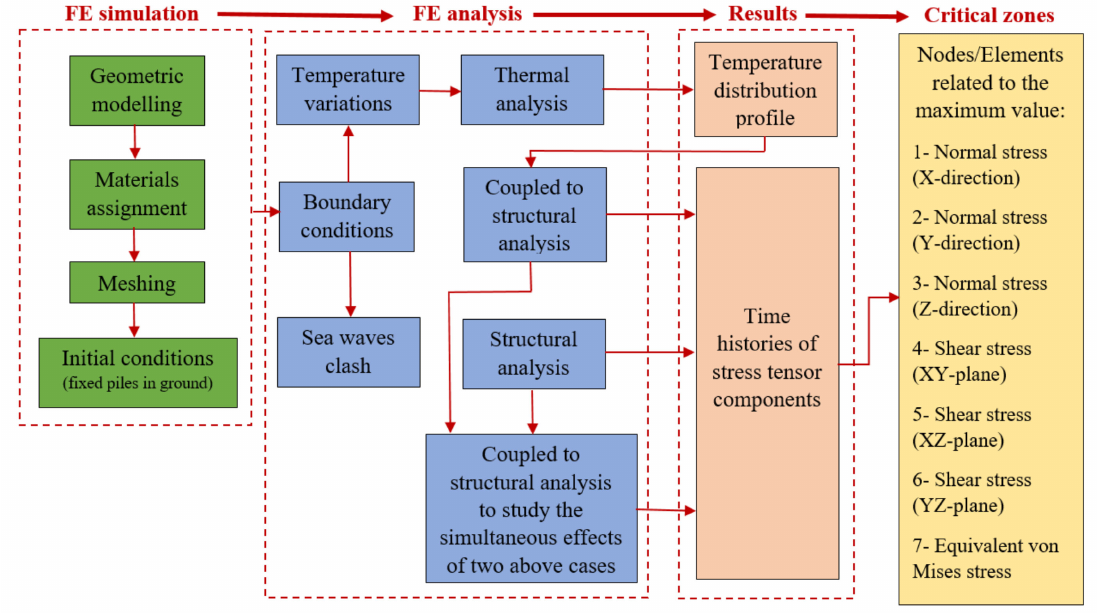
Figure 1. The proposed algorithm of the determination of critical nodes/elements in this case